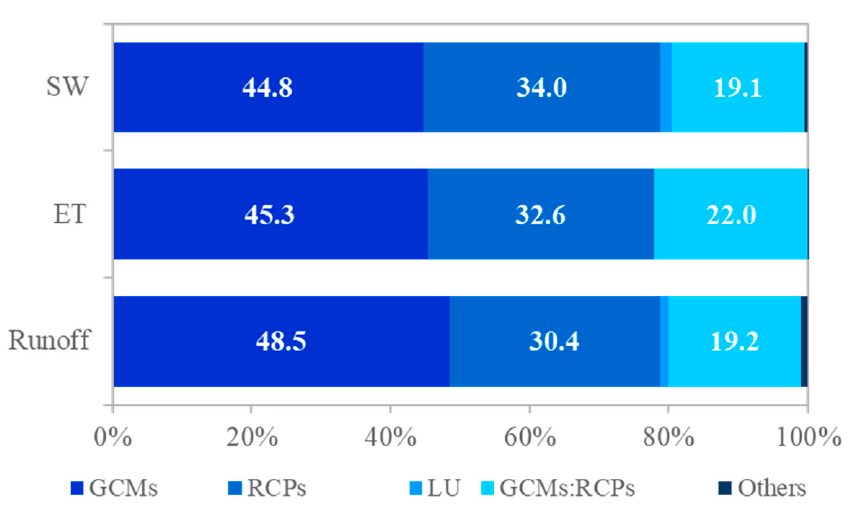
Figure 10. The contribution of uncertainty sources to the percentage change in annual runoff, ET, and SW using the three-way ANOVA.